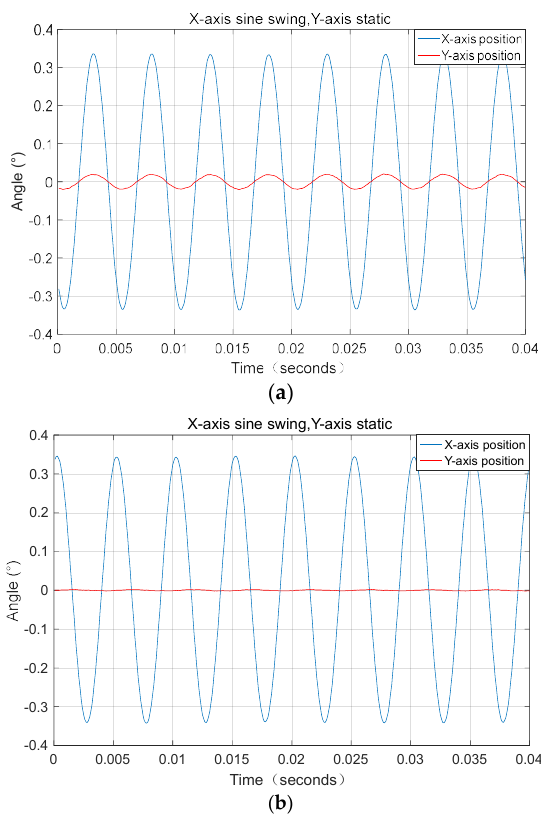
Figure 8. Comparison before and after decoupling. ( a ) Before sensor decoupling; ( b ) after sensor decoupling.